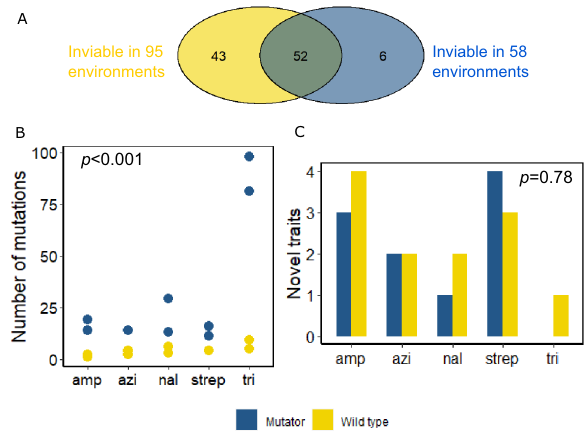
Fig. 1 | Mutation supply does not limit the emergence of novel traits without immediate bene fi t. A Before conducting any evolution experiments, we deter- mined the viability of both our ancestral wild-type and ancestral mutator strain in 236 different environments with Biolog phenotyping microarrays. The mutator strain was inviable in 58 environments, whereas the wild-type was inviable in 95 environments, as previously reported 5 . In 52 environments both the wild-type and mutator ancestors were inviable. B After ~200 generations of experimental evolu- tion in fi ve different simple (single-antibiotic)environments ( x -axis) the number of mutations ( y -axis) in evolved mutator clones (blue circles) was signi fi cantly higher than in the evolved wild-type clones (yellow circles) (Two-way ANOVA, F=115.77, df=1, p =8×10 − 7 ). C We determined the number of phenotyping environments in whichanevolvedstrainhadacquiredviability( y -axis)outofthetotalnumberof52 environments in which both the ancestors had not been viable before evolution. Thisnumberisstatisticallyindistinguishablefortheevolvedwild-type(yellowbars) andtheevolvedmutatorclones(bluebars)ineachofthe fi vesimpleenvironments ( x -axis, Two-sided Wilcoxon rank sum test, W=14.5, n =5 and 5, p =0.78). Source data are provided as a Source Data fi